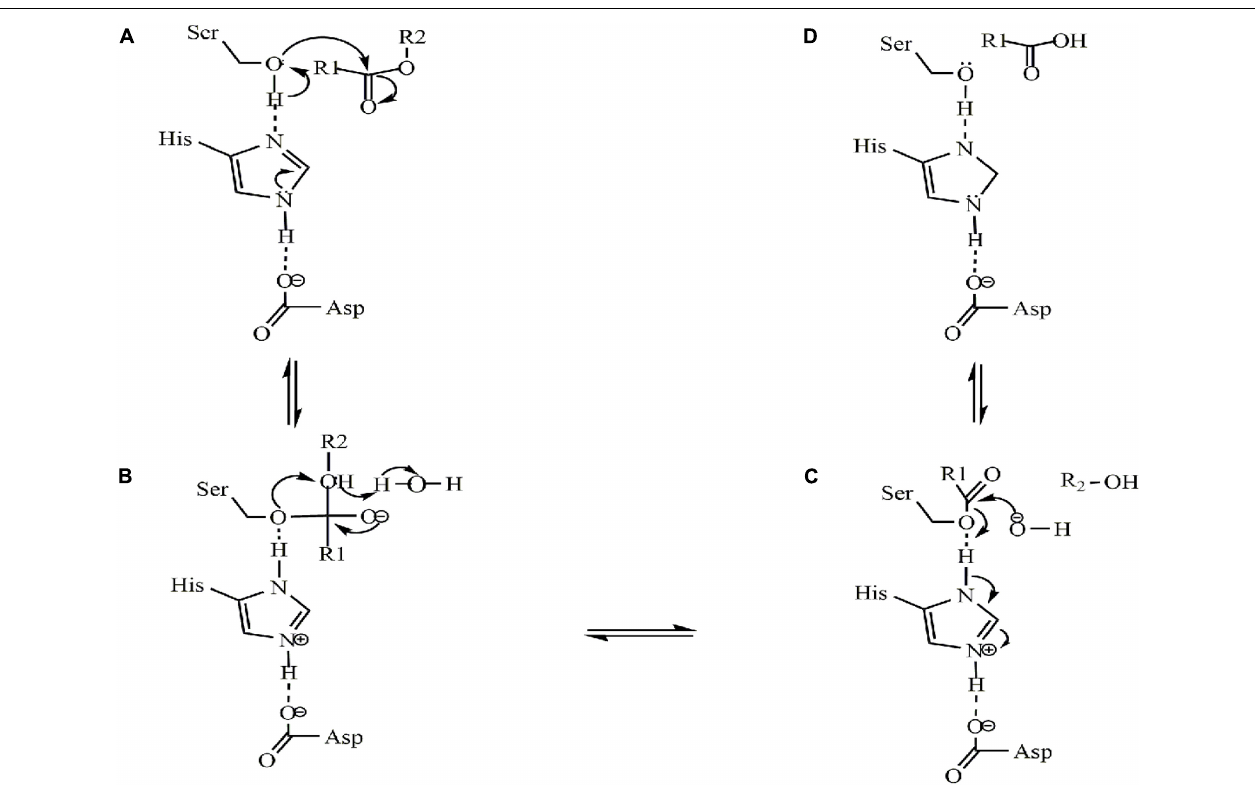
FIGURE 4 | The catalytic mechanism of lipase (Jaeger et al., 1999). (A) The enzyme binds to the substrate; (B) intermediate tetrahedral structures are formed; (C) acyl covalent intermediate complexes are formed; (D)